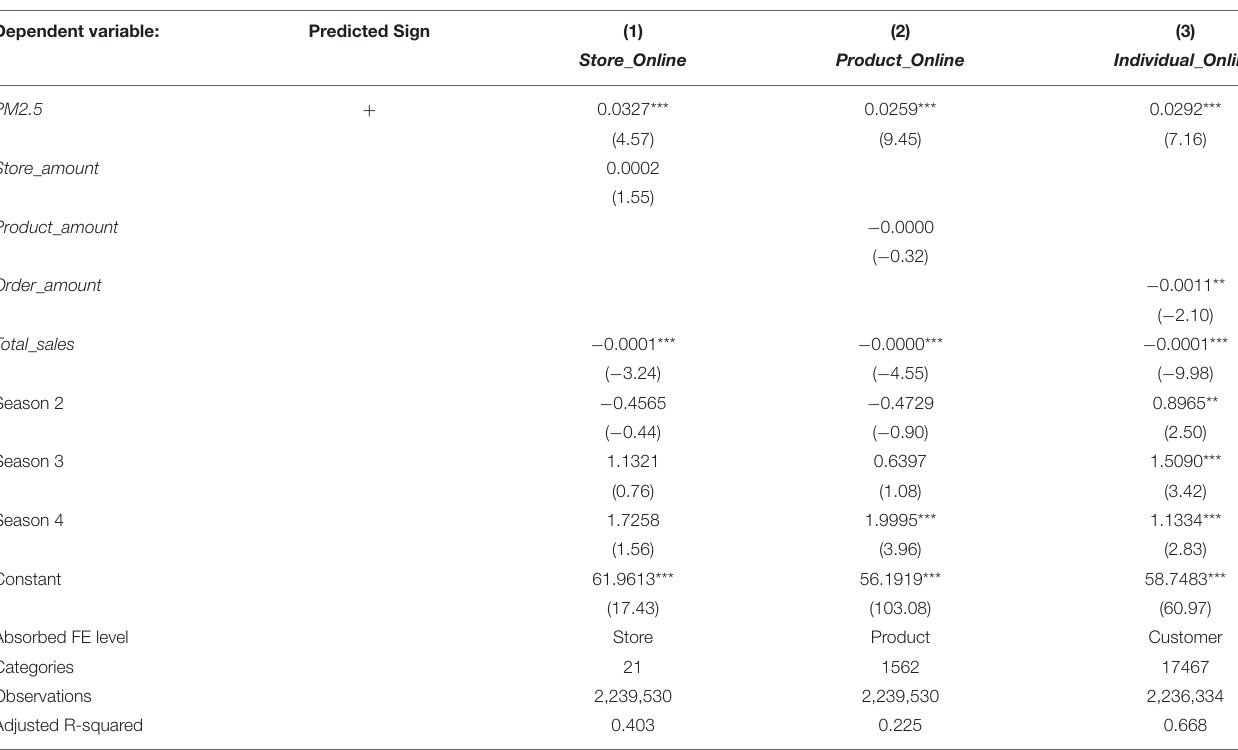
TABLE 6 | Main effect regression